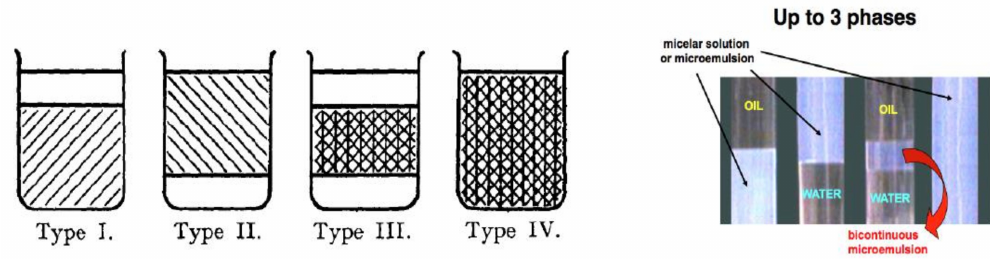
Figure 1. Di ff erent types of solubilization in a surfactant-oil-water (SOW) system according to the aspect type and Winsor R ratio: Type I when R < 1, Type III when R = 1 and Type II when R >